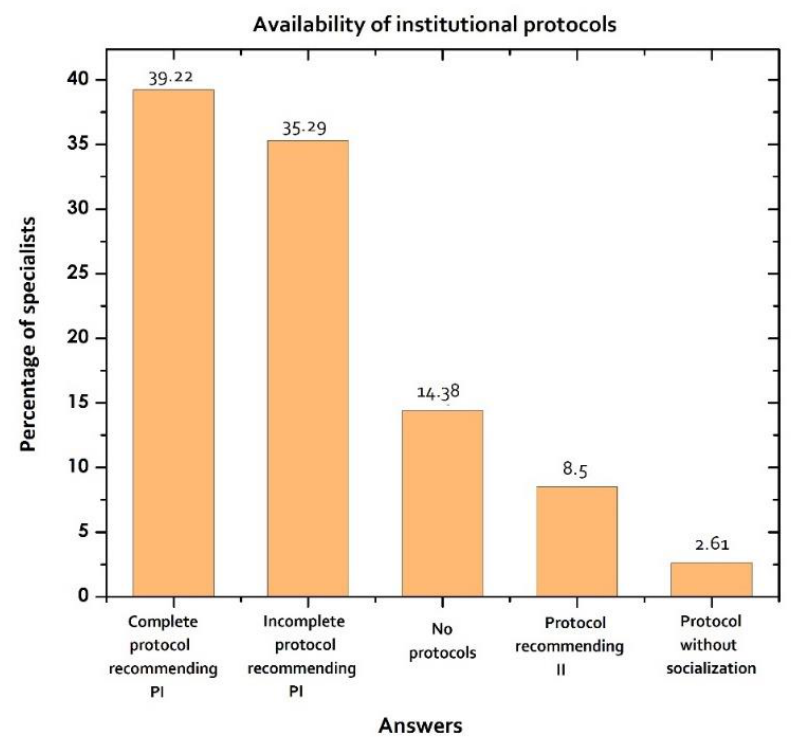
Figure 2. Characterization of the availability of institutional protocols to guide clinical practice. Complete protocols refer to those with additional information (product stability, dilution method and solution, maximum concentrations, duration of infusion, incompatibilities). PI: prolonged infusions, II: intermittent